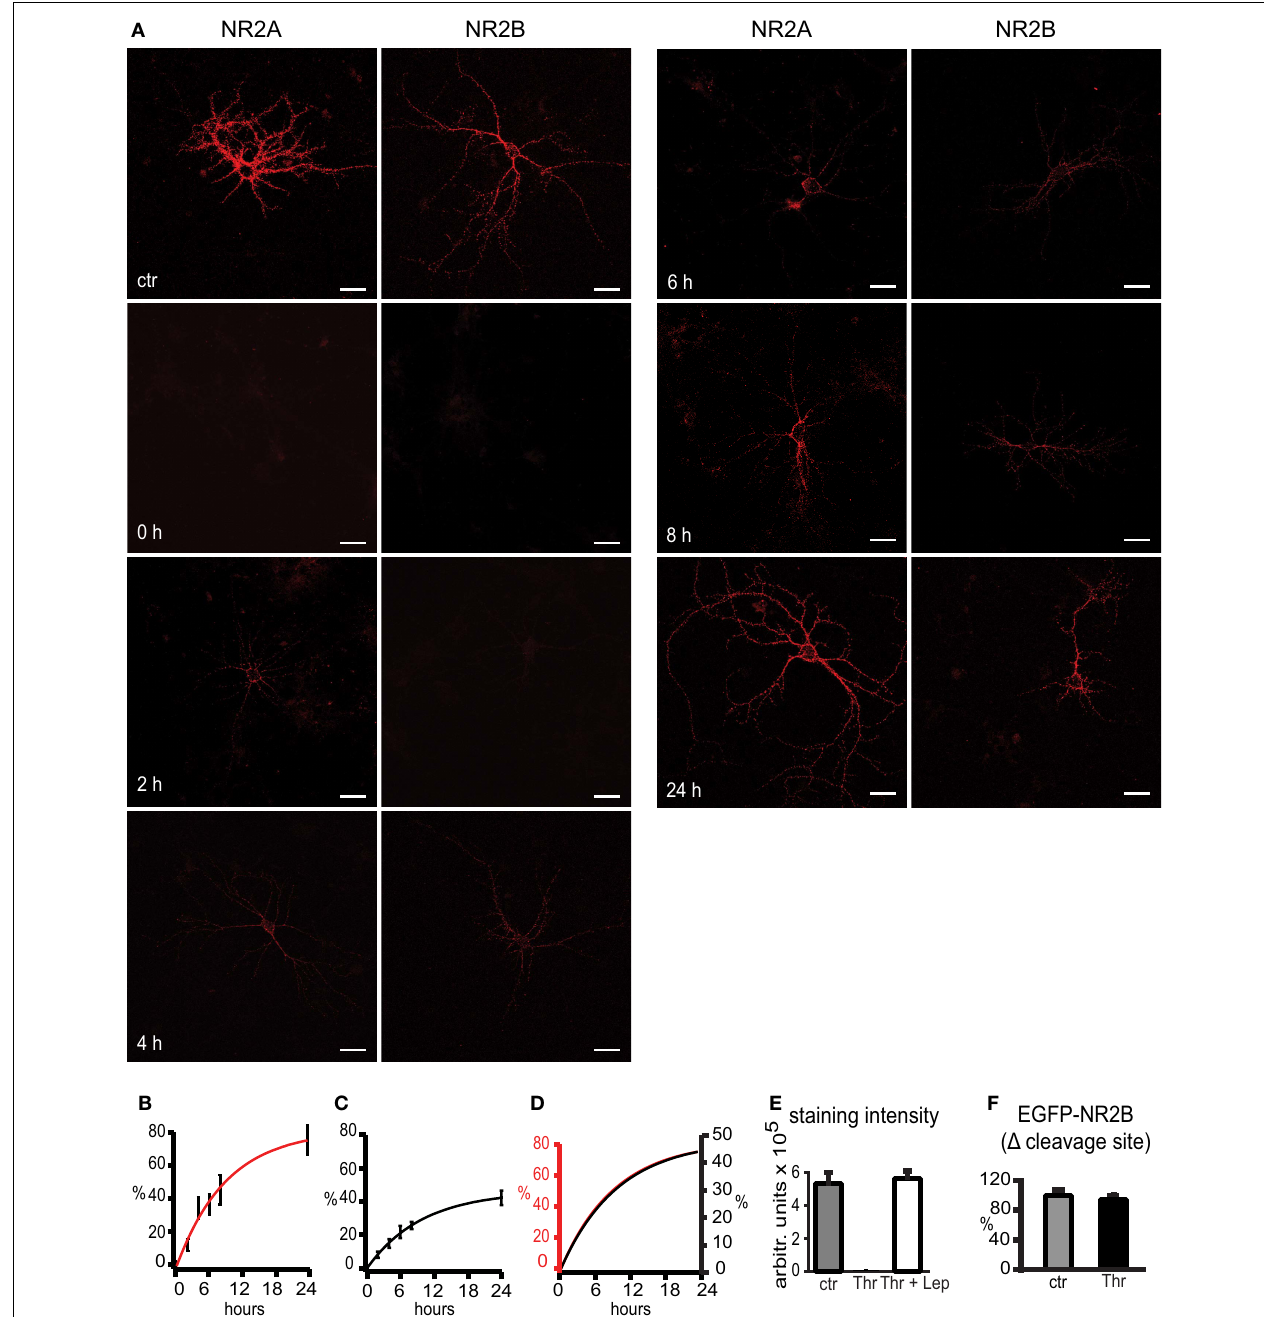
FIGURE 3 | Turnover of NR2A and NR2B receptors in the cell membrane occurs in the range of several hours. (A) In control condition (ctr), thrombin and lepirudine were added simultaneously. Surface staining of the EGFP-tag under non-permeabilizing conditions shows strong staining of cell membrane- bound receptors, confi rming the potency of lepirudine in blocking the thrombin activity. Thrombin treatment for 30 min effectively cleaved off the extracellular EGFP, as revealed by loss of EGFP immunoreactivity (0 h). With the insertion of new receptors into the cell membrane, EGFP immunoreactivity increased between 2 and 24 h (2–24 h). Scale bars: 40 µm. (B,C) After 24 h the signal was 75% and 42% of the control signal for NR2A- (B) and NR2B-type (C) receptors respectively. In (D) the mono-exponential fi ts for the NR2A (red, left y -axis) and